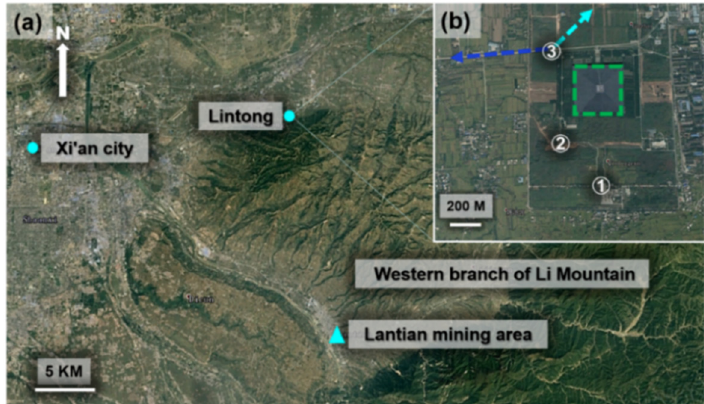
Figure 1. Overview schematic of the measurement site in the Lintong district of Xi’an city. ( a ) The location with respect to Xi´an city and a mercury mine location. ( b ) Close-up of the Lintong district. The three spots labelled with different numbers indicate the different locations of the lidar system during measurements, while the green, dashed line marks the position of the emperor Qin mausoleum mound. A 360° scanning monitoring was conducted at site 1. Vertically resolved measurements of the concentration were made at site 2. Finally, from site 3, the atmospheric mercury content in two different directions was measured, with one pointing towards the urban area and the other one towards the suburban area.